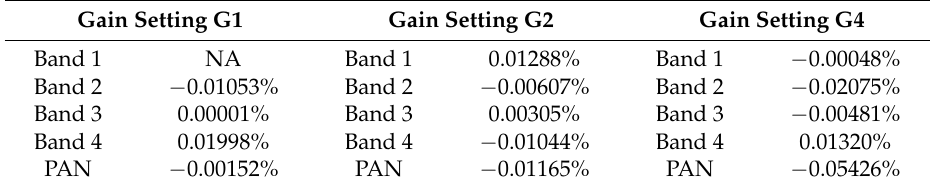
Figure 13. Comparison of relative response coefficient of the sensor’s detector chips for flying mode test imagery for gain setting G2. ( a ) Results of the EMD–HHT method from this study; ( b ) results of the NSPO; ( c ) overlapping curves of ( a ) and ( b ). Table 7. Comparison and analysis of the mean error of the relative response coefficients after calibration in the spatial variation on flying mode test imagery for all bands of various gain settings. The mean error for all gain settings and bands is 0.012%.